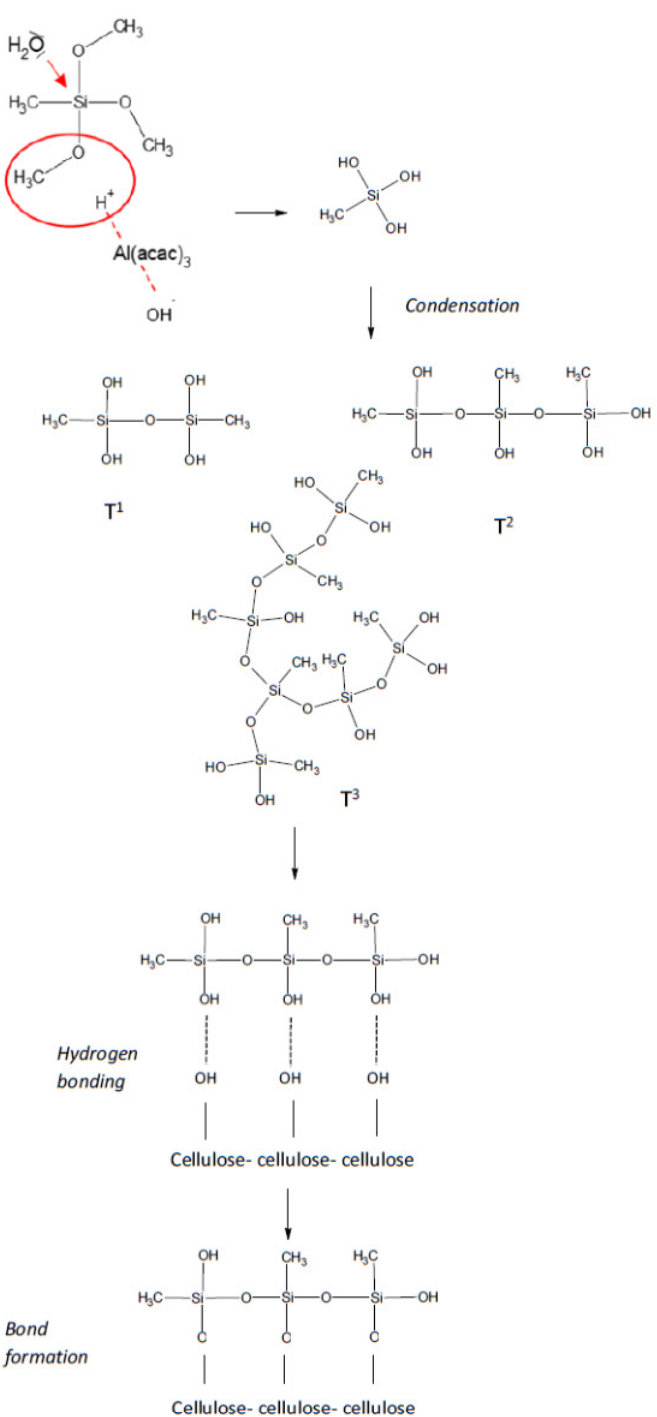
Figure 7. Presumed mechanism of MTMOS bonding to cellulose.